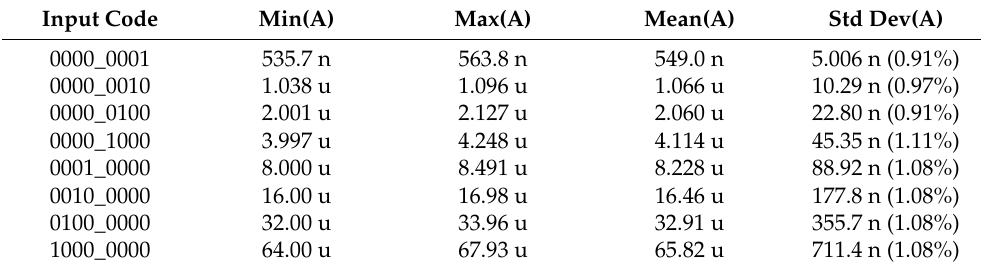
Table 1. Monte Carlo Simulation Results of the DAC Output